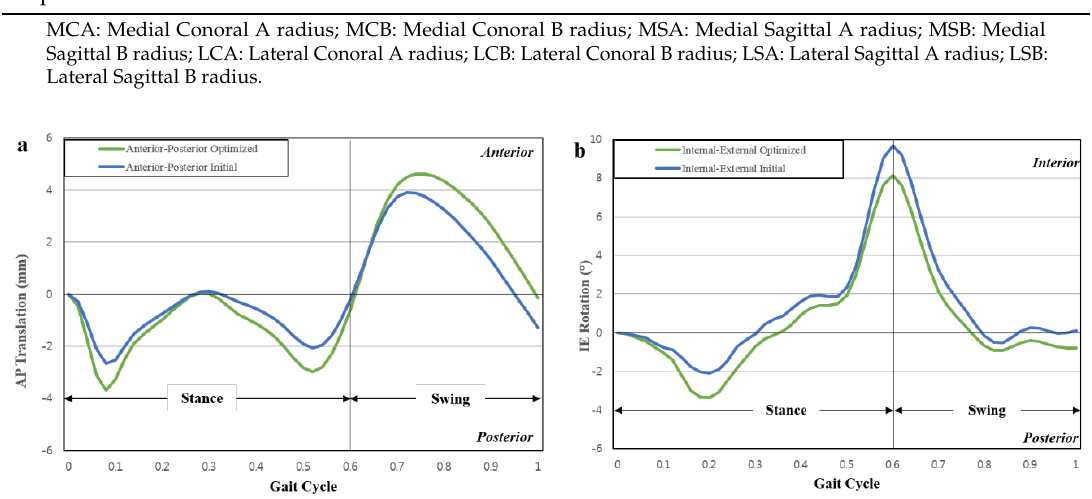
Table 1. Design variables: Initial versus optimal design.